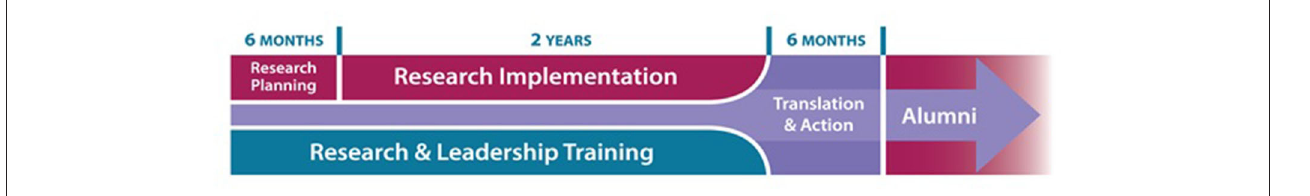
FIGURE 1 | Schema depicting the IRL program fellowship years.